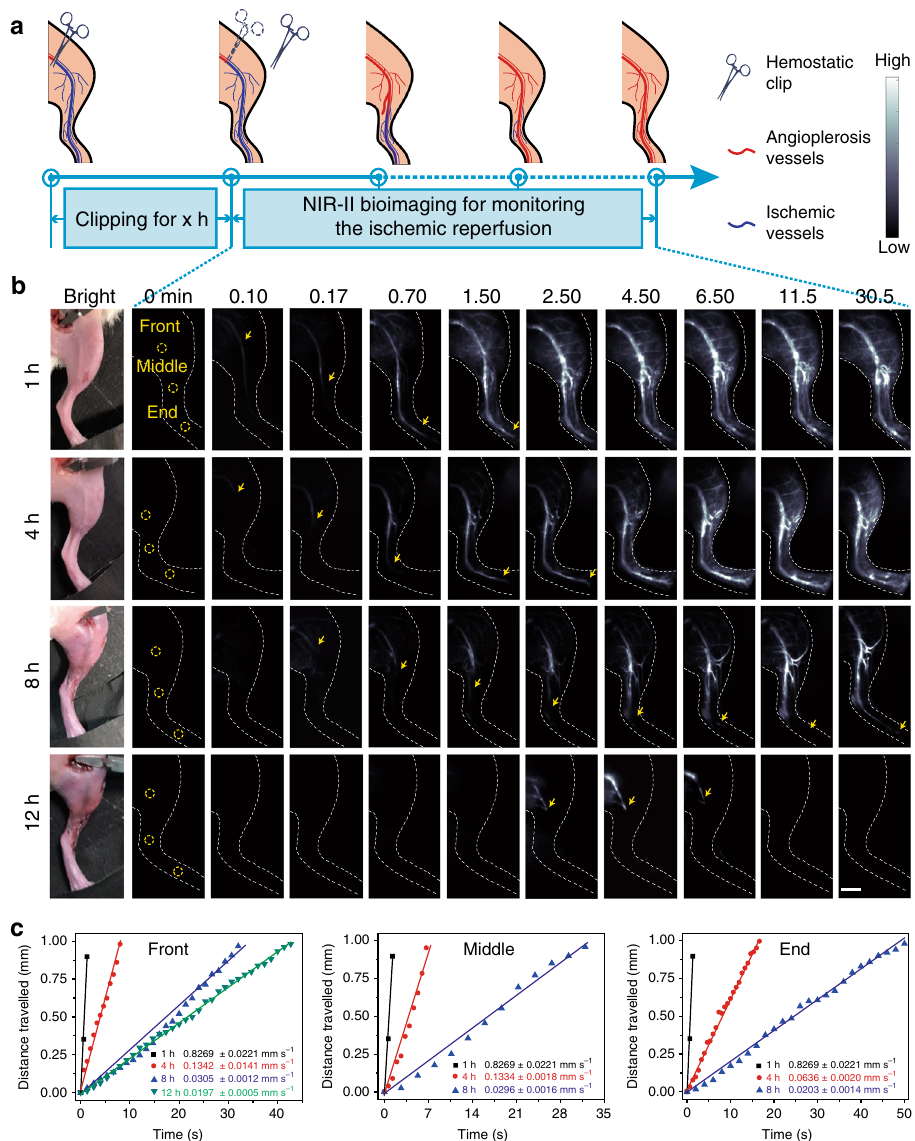
Fig. 3 Real-time NIR-II imaging of the ischemic reperfusion in hindlimbs. a Schematic illustration of the ischemic reperfusion process. b NIR-II bioimaging with LZ-1105 administration of ischemic reperfusion at different time points after various period clipping treatment (1400 nm long-pass, λ ex = 1064 nm, 300 ms) as indicated. Three regions of interest (ROI) named as the front, middle, and end sites as shown with yellow circles were chosen to evaluate the ischemic reperfusion process. Yellow arrows indicate the fl ow front. c The corresponding distance traveled by the fl ow front at the front, middle, and end site as a function of time after 1, 4, 8, and 12 h clipping, respectively. The slope of the function was calculated as blood fl ow velocity (BFV) and indicats mean ± s.d. derived from n = 3 replicated measurements. Scale bar represents 4 mm. Source data underlying c is provided as a Source Data fi